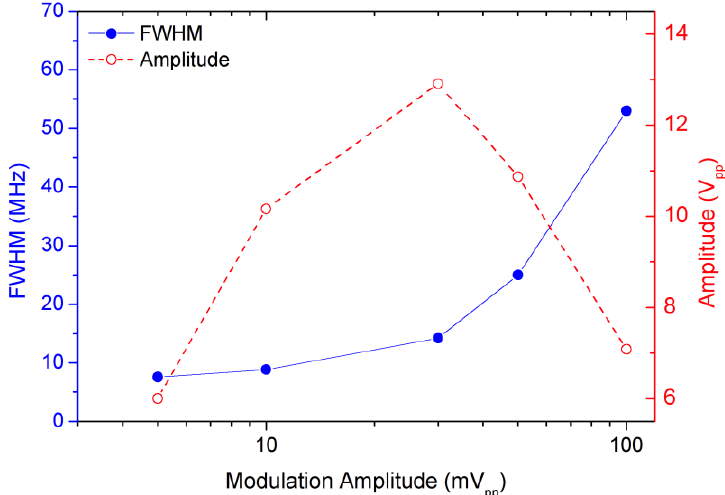
Figure 5. Dependence of the amplitude and width of the WMS signal on the amplitude of the modulation signal. A modulation of 10 mV significant profile